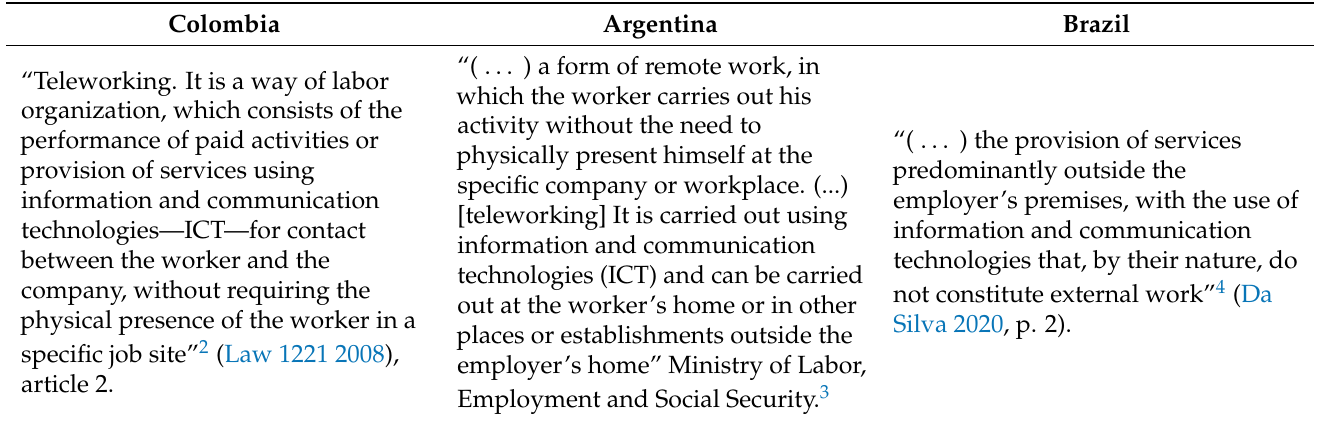
Table 1. National definitions for teleworking in Latin